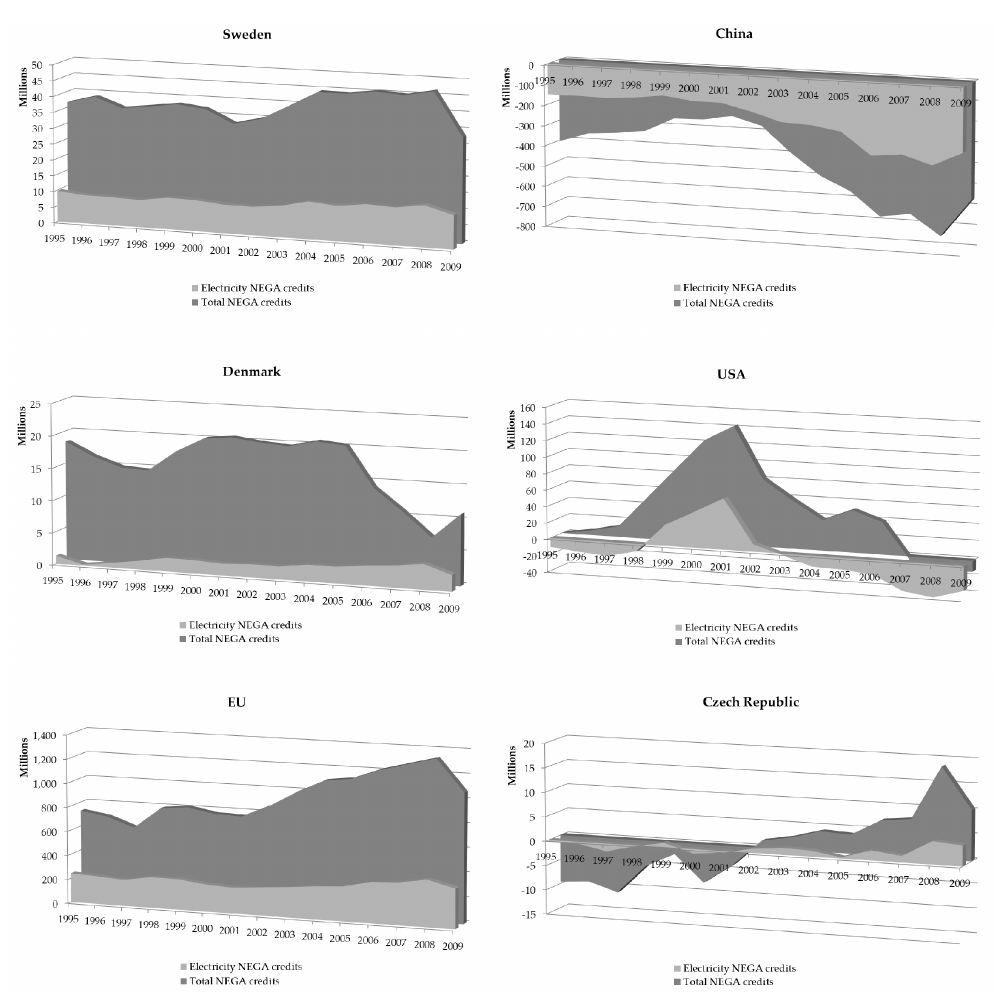
Figure 4. NEGA credits in exports (total NEGA) and embodied NEGA credits from electricity consumption (electricity NEGA) in a comparative perspective, in M tons of CO 2 emissions. Note: Negative NEGA credits correspond to ‘penalties’ for having worse than world average carbon e ffi ciency. The scale of the y ‐ axis differs by country.